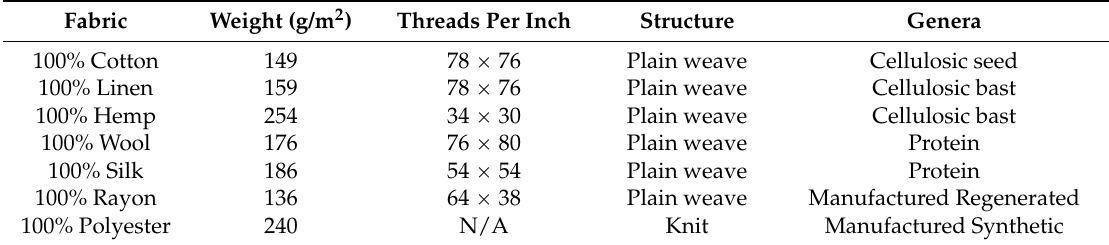
Table 1. Test fabrics. All fabrics are unbleached and undyed.